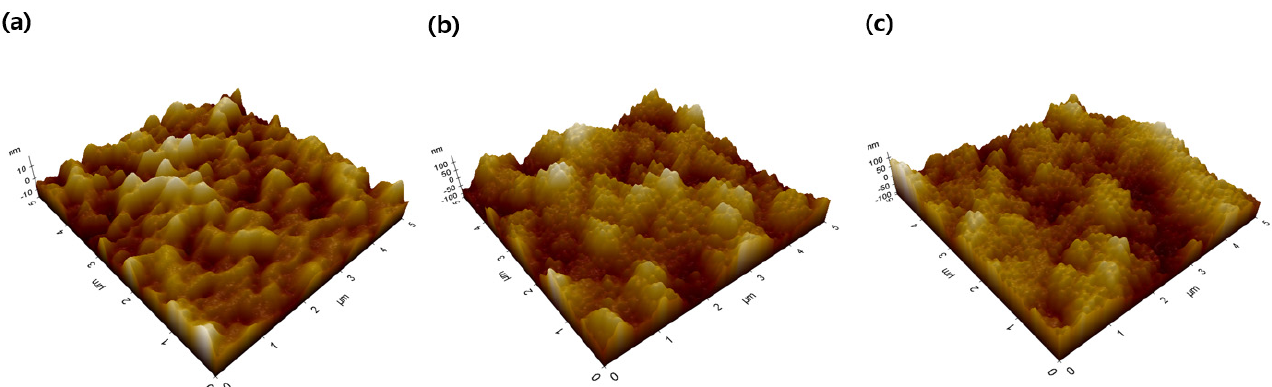
Figure 7. AFM 3D images of coating surfaces: ( a ) PIFSS-5, ( b ) PIFSS-10, and ( c ) PIFSS-15. The RMS roughness values of the coating surfaces were determined as ( a ) ~4.34 nm, ( b ) ~30.67 nm and ( c ) ~35.84 nm.